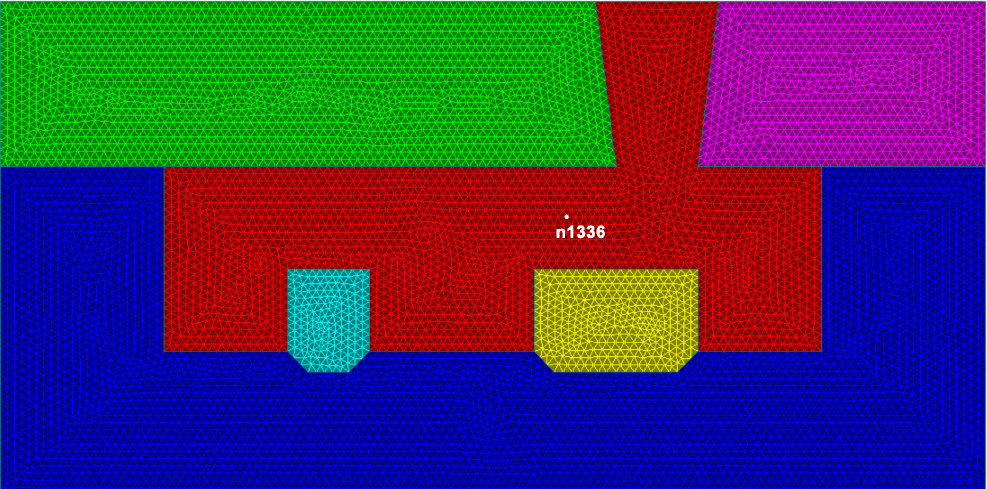
Figure 6. Finite element mesh in analyzed